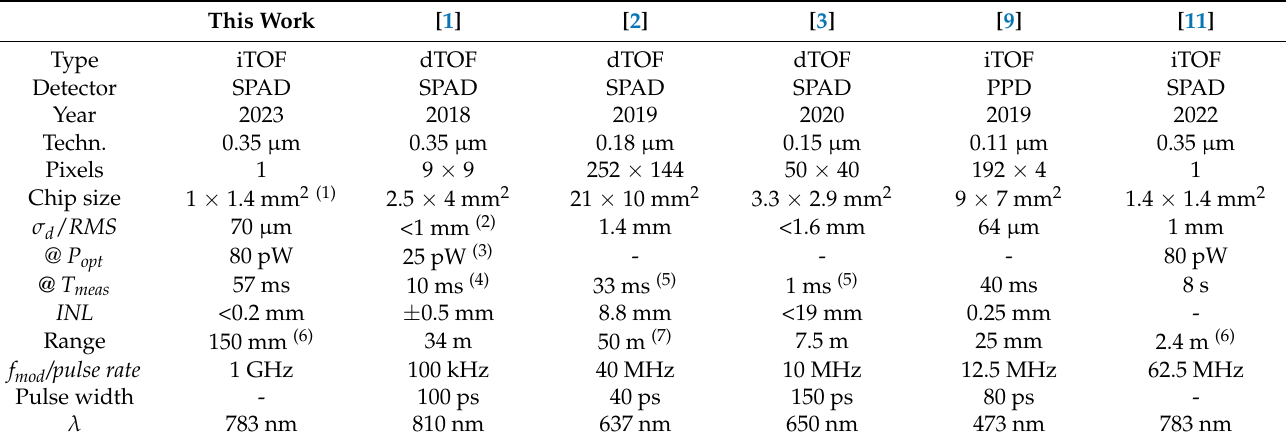
Table 1. Comparison of integrated dTOF and iTOF